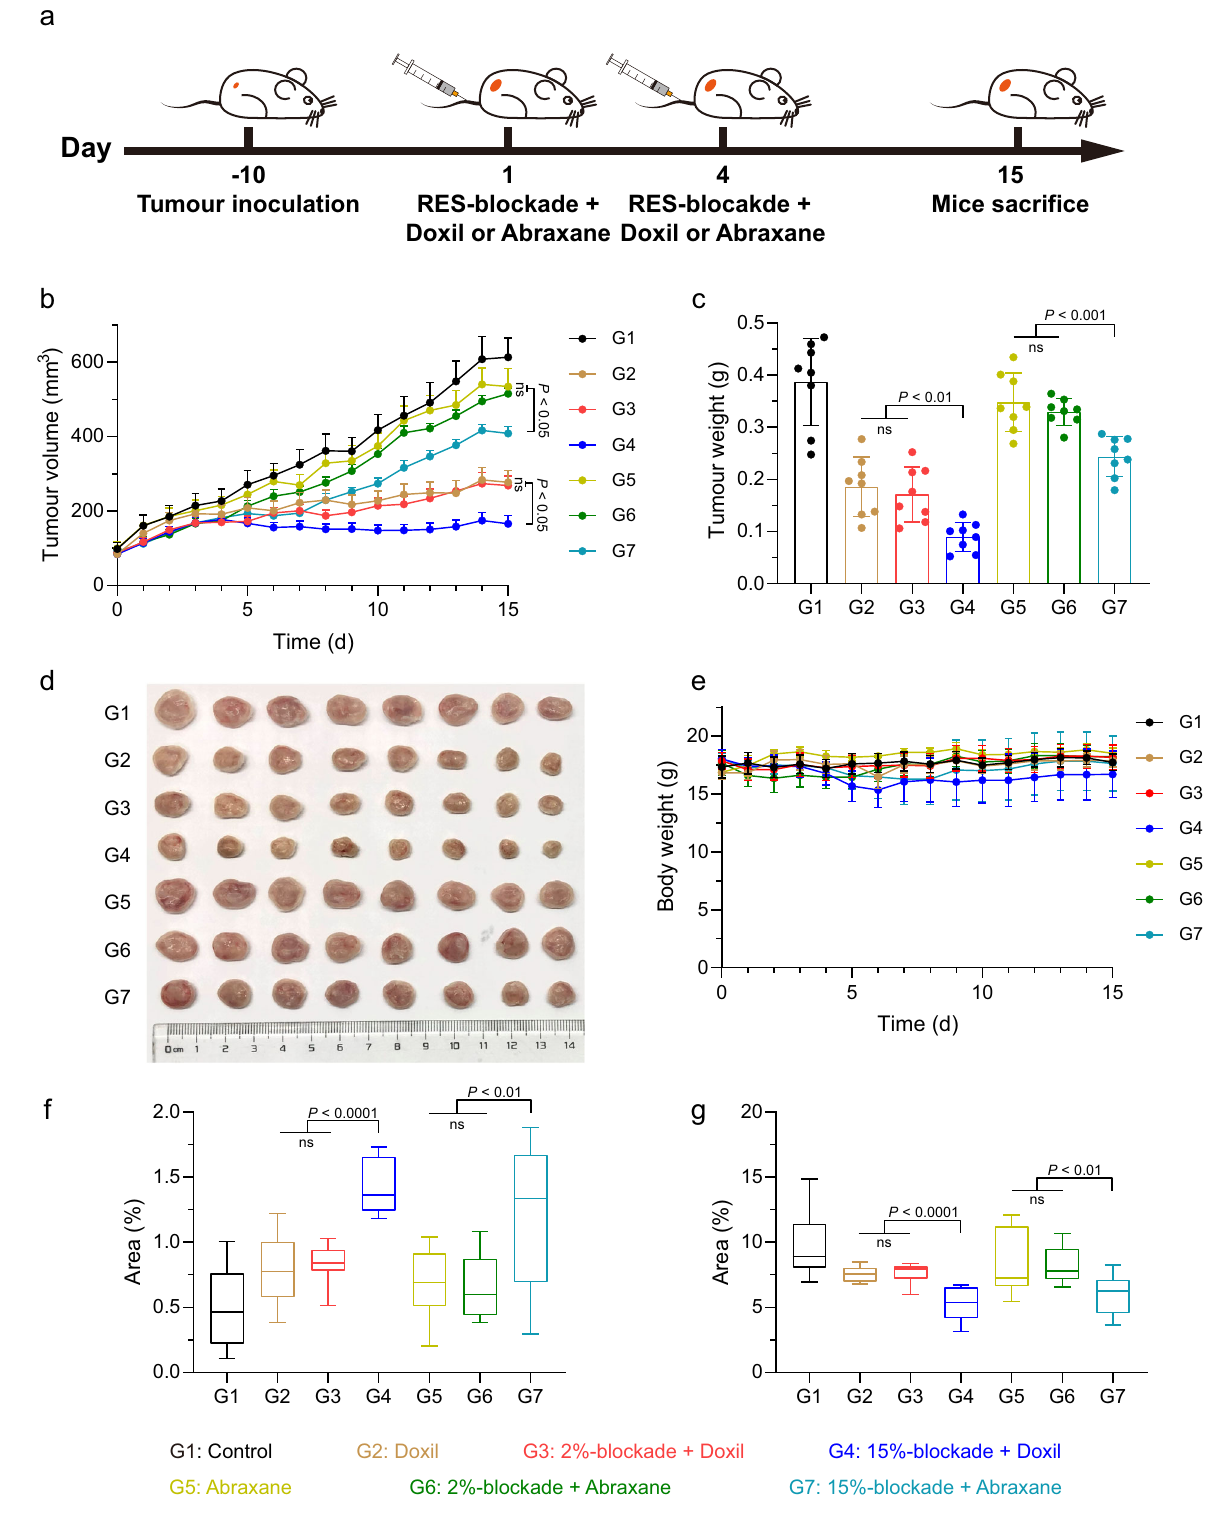
Fig. 7 | Blockade by stiff nanogels boosting the antitumour ef fi cacy of com- mercializednanomedicine.a Illustrationofdrugadministrationstrategy. b Tumor growth pro fi les of 4T1 tumor-bearing mice treated by commercialized nanomedi- cine with or without RES-blockade by soft or stiff nanogels at blockade dosage of 200mg/kg, DOX dosage of 3mg/kg or paclitaxel dosage of 10mg/kg. Data are presentedasmeanvalues±SEM( n =8biologicalindependentreplicates). c Weight of tumorsaftertreatment.Dataarepresentedasmeanvalues±SD ( n =8biological independent replicates). d Photograph of tumors extracted from the mice after